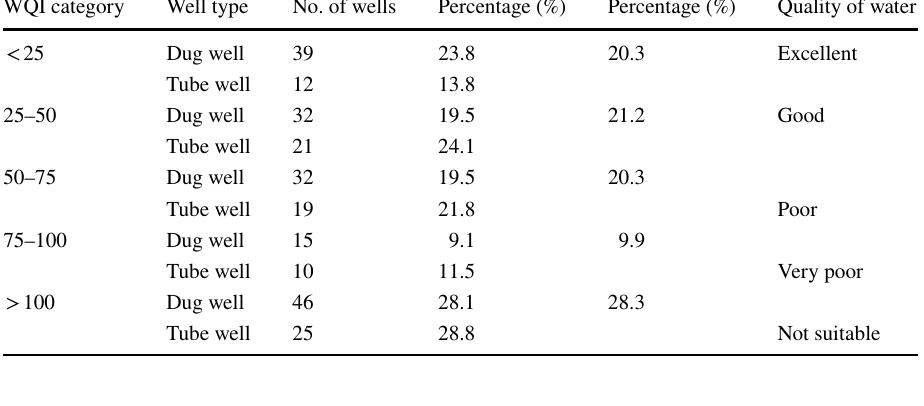
Fig. 6 Pie charts show ground- water quality classification based on the WQI categories and type of groundwater